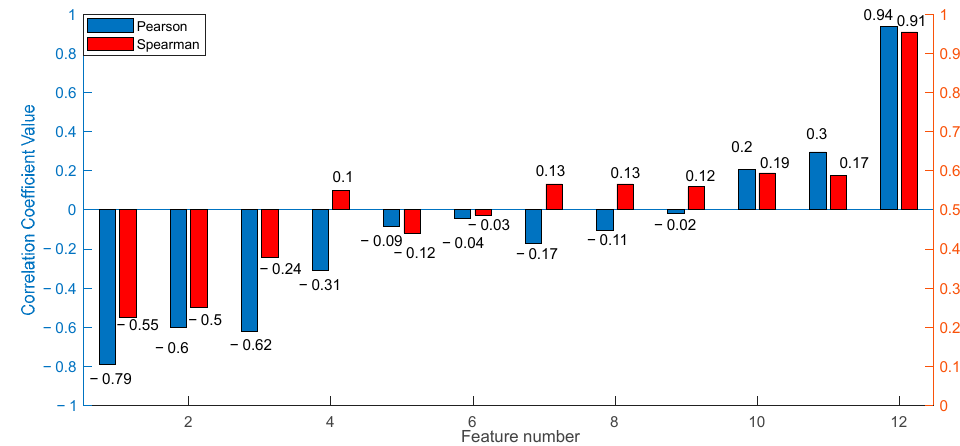
Figure 8. Pearson and Spearman correlation coefficients between characteristics and capacity.